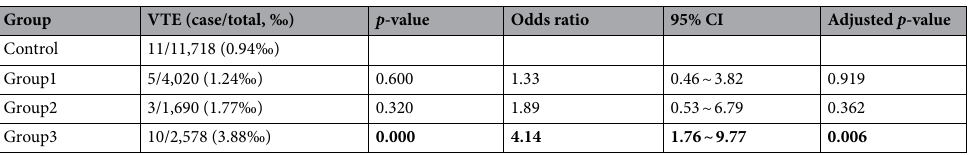
Table 5. Rate of TE in different AR conditions in CS subjects. Significant values are in bold. Group 1: with AR before; without AR after childbirth. Group 2: without AR before; with AR after childbirth. Group 3: with AR before; with AR after childbirth. Adjusted p -value: adjusted for AS, medical comorbidities, pregnancy characteristics, delivery complications, urbanization, jobs and